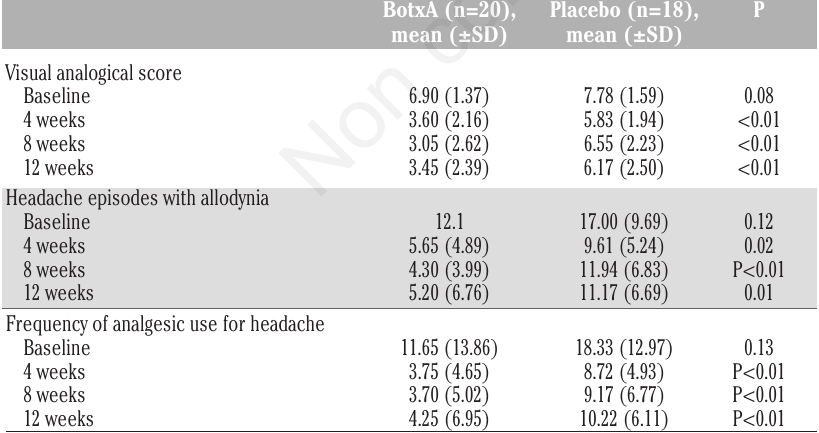
Table 3. Mean changes in primary and secondary endpoints from baseline to week 12.